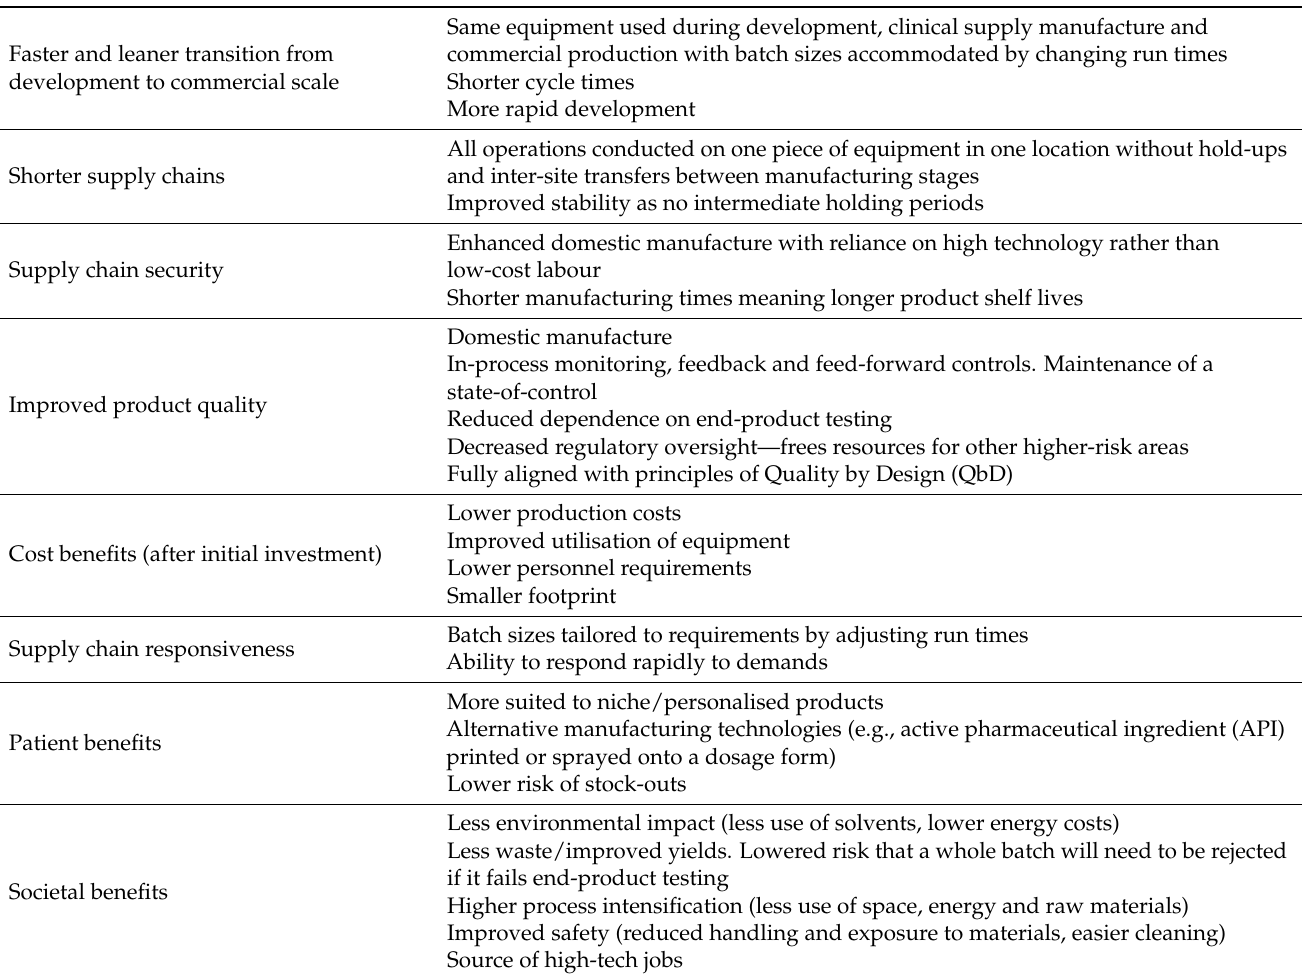
Table 2. Benefits of adopting